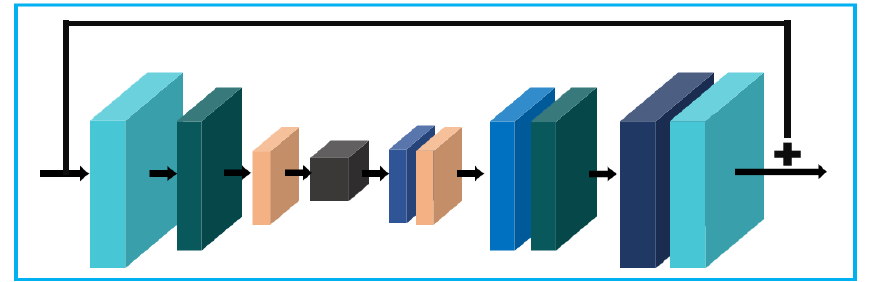
Figure 2. Res-U-net module for our